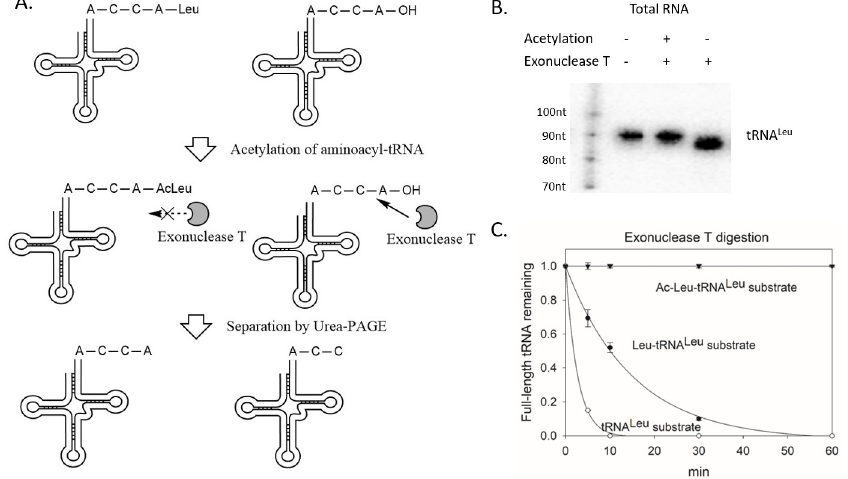
Fig 1. Exonuclease T digests the nucleotide A from 3´-end of uncharged tRNA. (A) Illustration of the enzymatic method to differentiate charged and uncharged tRNAs. (B) Uncharged tRNA Leu digested by exonuclease T is 1 nt shorter than charged tRNA Leu in a northern blot. Total RNA from HeLa cells was treated with or without N -acetylation, with or without exonuclease T digestion, and loaded on a 15% urea acrylamide gel. Radiolabeled RNA marker with various sizes were loaded in the left lane. A northern blot was performed using the tRNA Leu probe. (C) N -acetylation protects Leu-tRNA Leu from deacylation and digestion with exonuclease T treatment. E . coli acetylated- Leu-tRNA Leu (inverted triangle). Leu-tRNA Leu (solid circle), uncharged tRNA Leu (open circle) were prepared and subjected to exonuclease T digestion at room temperature. Samples were taken and quenched on ice at time points of 0, 5, 10, 30, 60 mins. Northern blots were used to detect the 1nt size difference after digestion. Levels of digested versus undigested tRNAs were quantified by Quantity One with three independent